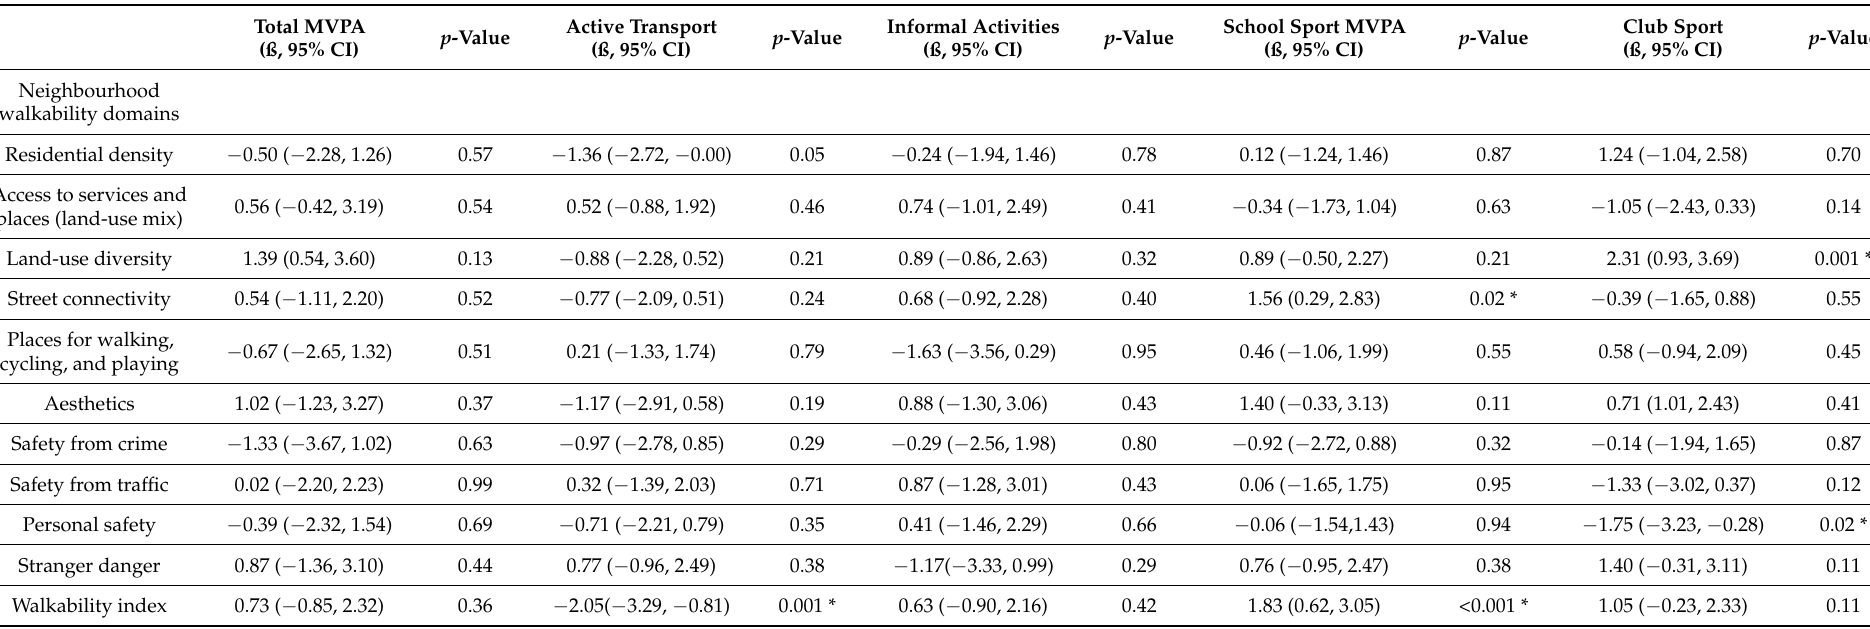
Table 3. Unadjusted associations of perceived neighbourhood environmental attributes with physical activity domains in urban South